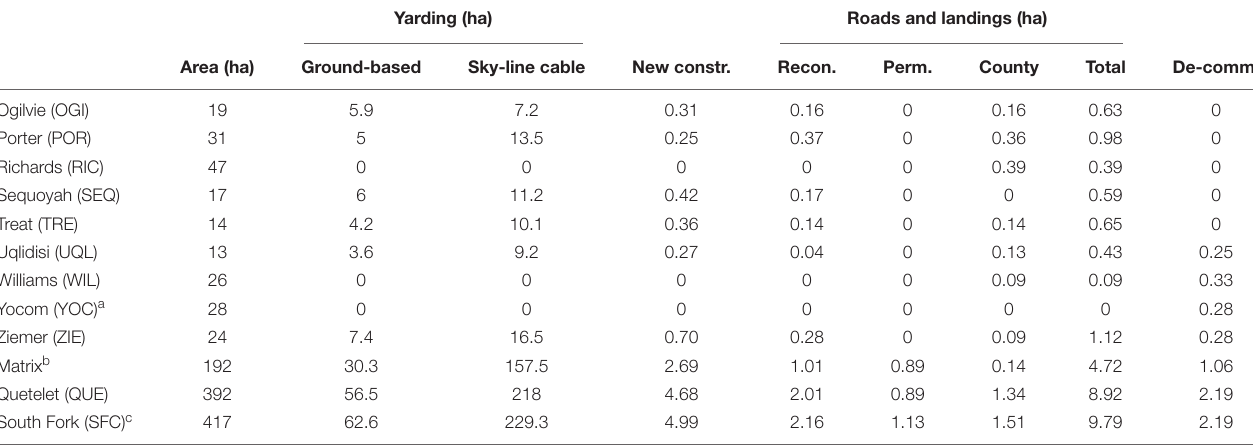
TABLE 4 | Area affected by ground-based or sky-line yarding methods, log-loading landings, and different classes of roads by sub-watershed in the South Fork of Caspar Creek. Yarding (ha) Roads and landings